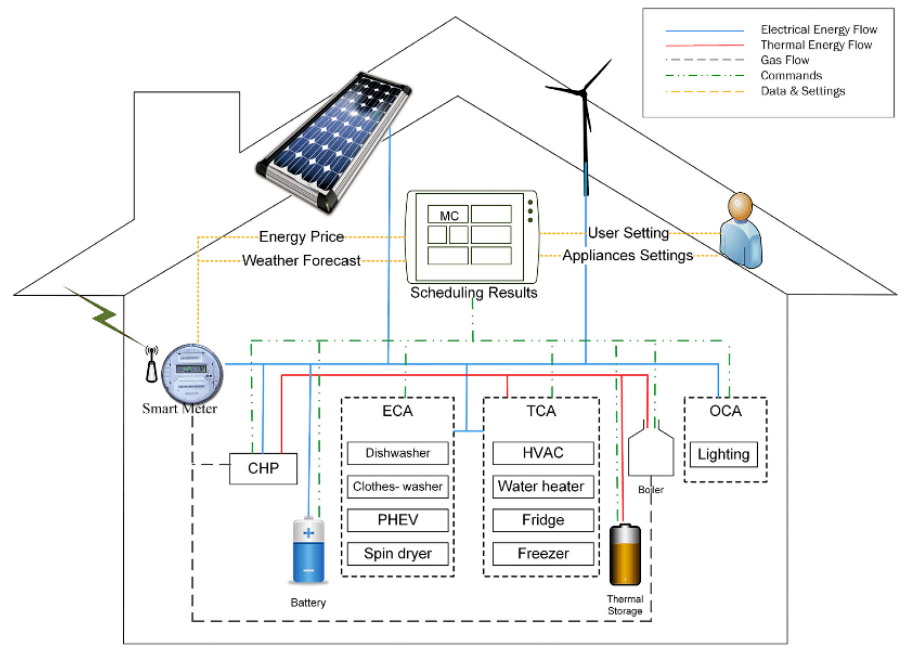
Figure 6. The proposed architecture [49]. Reproduced by permission of Springer.